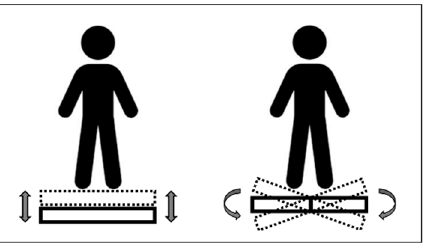
Figure 1. Standing on a platform with vertical vibrations ( left ) versus side-alternating vibrations ( right ).